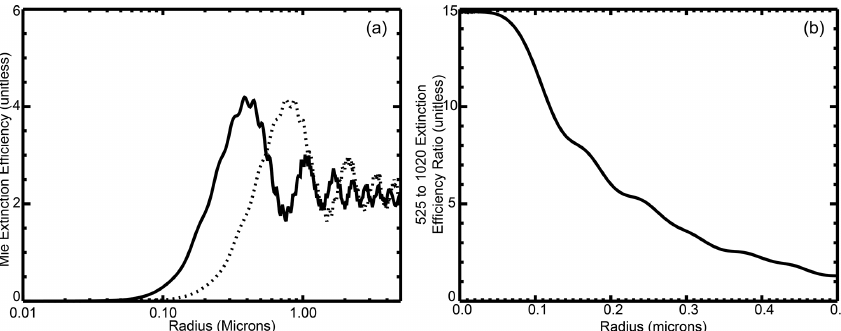
Figure 2. (a) Mie extinction efficiency for sulfuric acid droplets at stratospheric temperatures at 525 (solid) and 1020nm (dashed). (b) The ratio of extinction coefficient at 525 to 1020nm for single particles as a function of radius for sulfuric acid aerosol at stratospheric tempera-